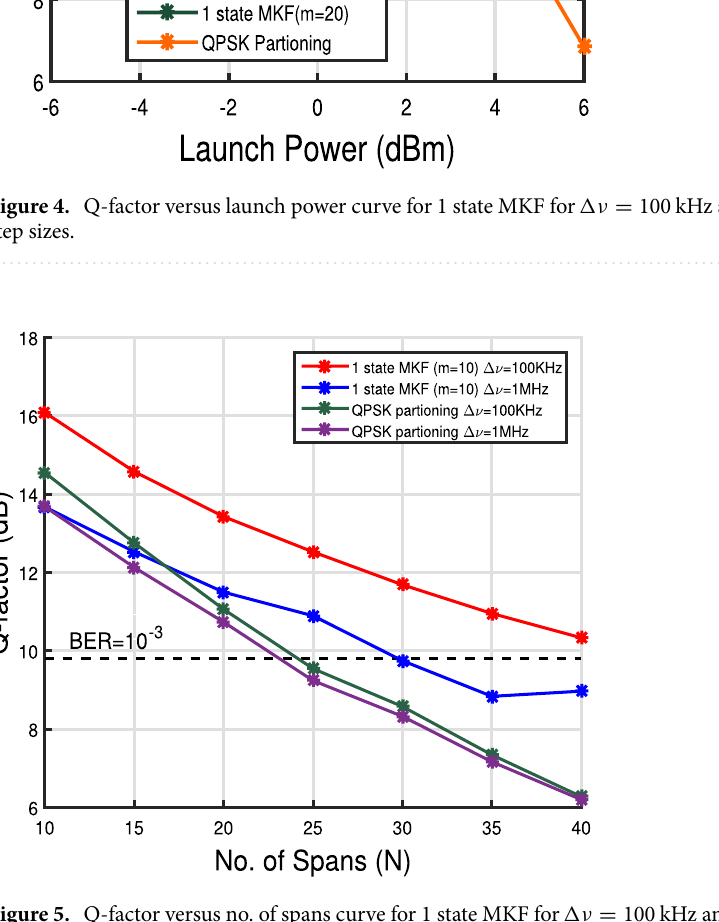
Figure 5. Q-factor versus no. of spans curve for 1 state MKF for �ν For reference, Q-factor corresponding to the BER of 10 −